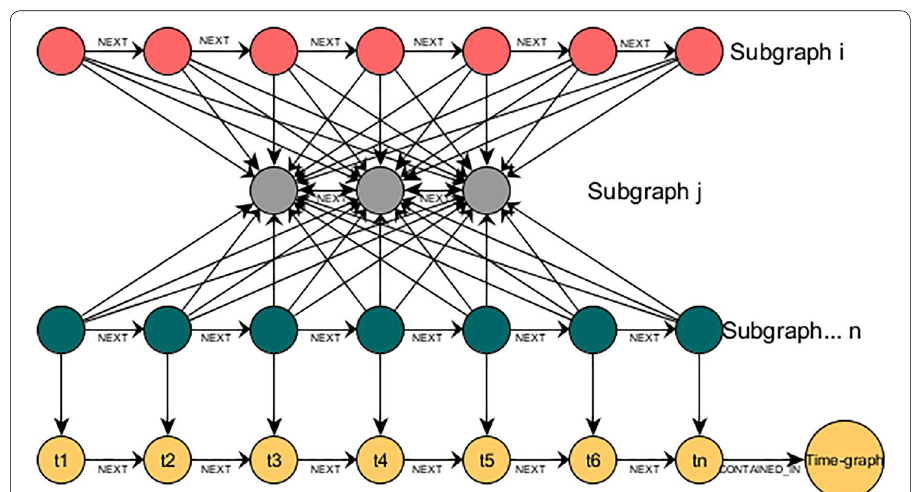
Fig. 2 Connectivity between the subgraphs and the